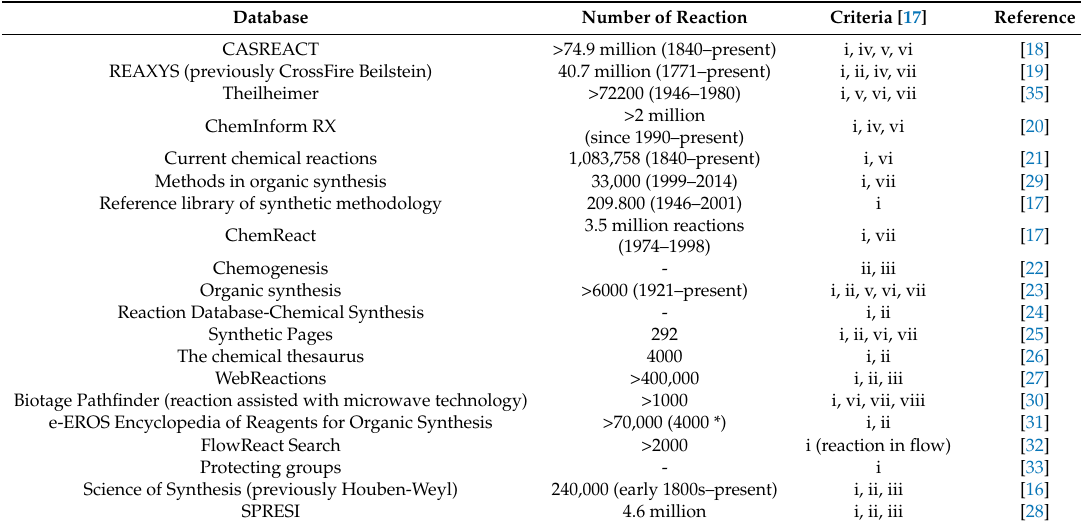
Table 1. Database review. All the databases have been summarized with respect to the number of reactions and the focus of the